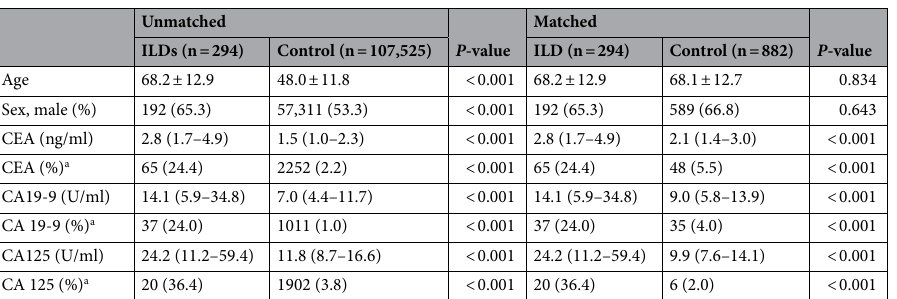
Table 1. Comparison of baseline characteristics between patients with ILDs and healthy controls. Data are expressed as mean ± standard deviation (SD), median (interquartile range), or frequency (%). The number of patients with available CEA, CA 19-9, and CA 125 results in matched cohort were 1143, 1034, and 348, respectively. ILD interstitial lung disease, CEA carcinoembryonic antigen, CA carbohydrate antigen. a Proportion of abnormal tumor marker values (normal range: CA 19-9, 0–37 U/mL; CA 125, 0–35 U/mL; CEA, 0–5